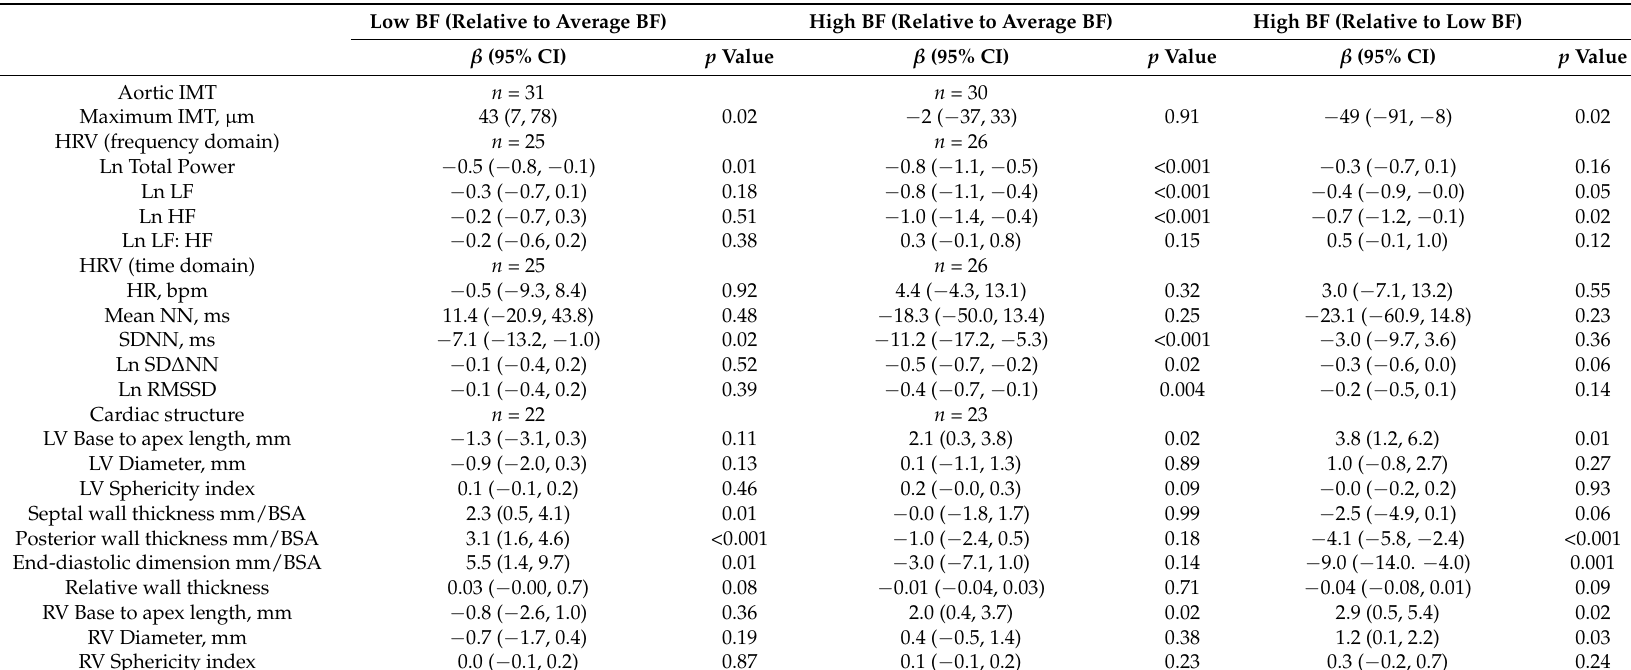
Table 2. Infant body fatness and aortic intima-media thickness, heart rate variability and cardiac